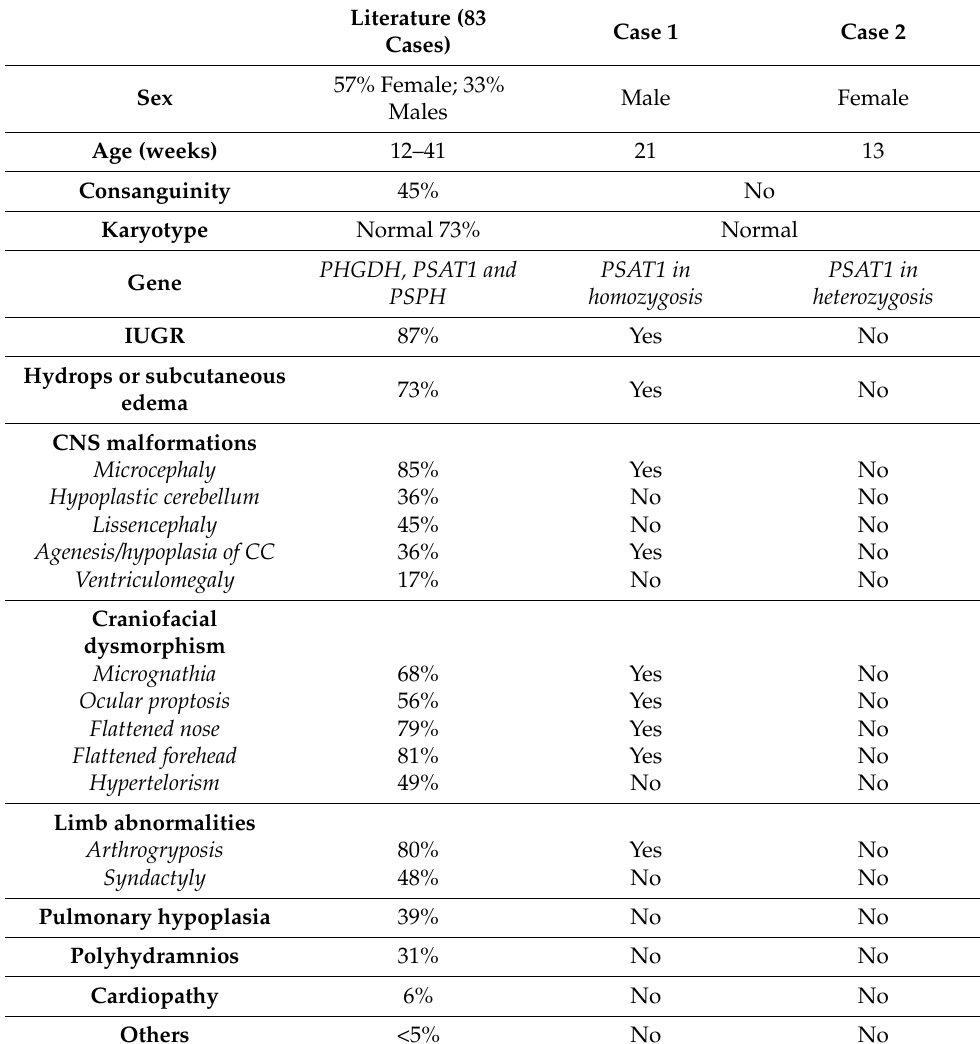
Table 1. Review of NLS cases published to date, representing the most important clinical and ultrasound